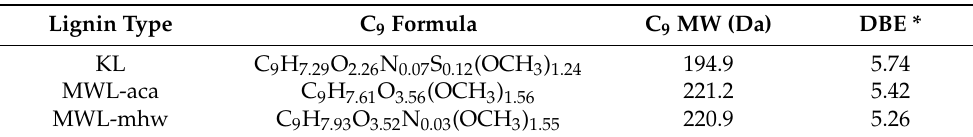
Table 3. C 9 formula, C 9 MW, and DBE of KL and MWLs.